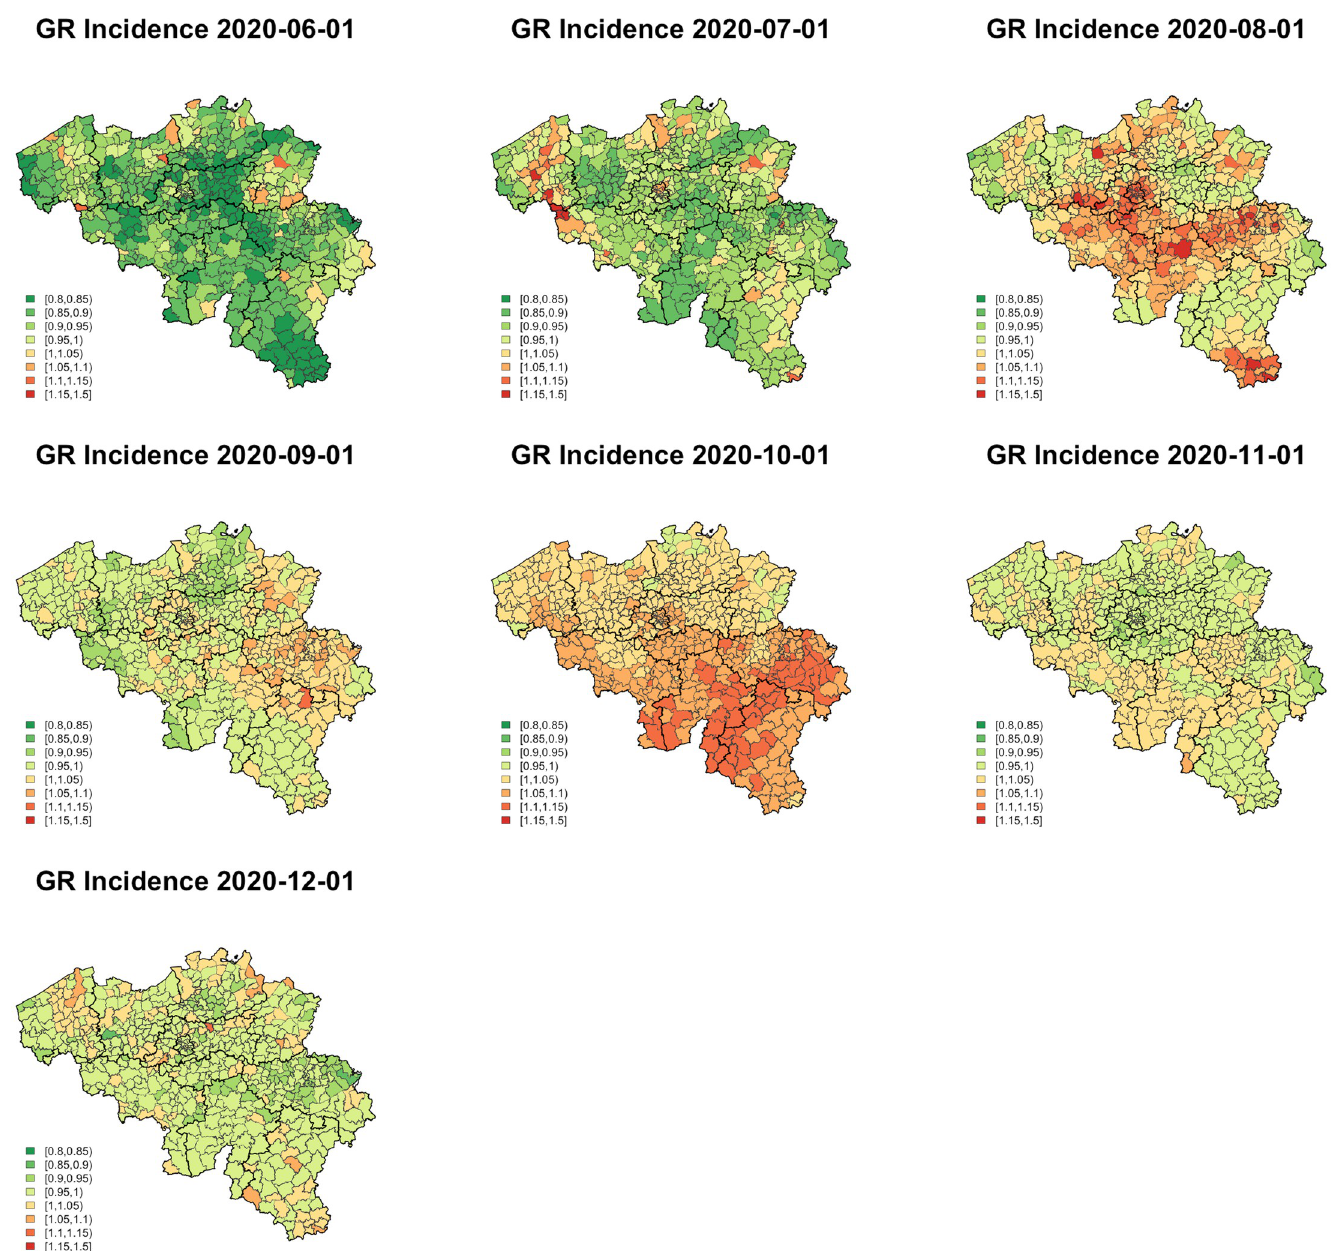
Fig 4. Municipality-level growth rate in incidence between June and December